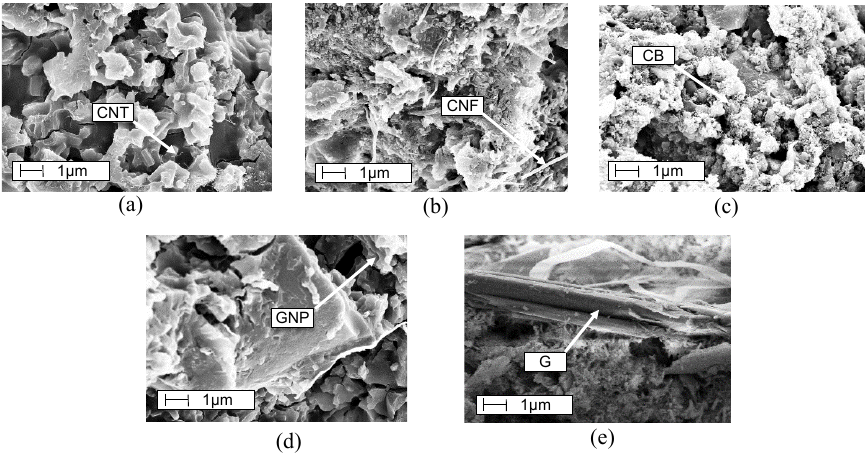
Figure 4. SEM inspection of cement–matrix composite with ( a ) Carbon Nanotubes—CNT; ( b ) Carbon